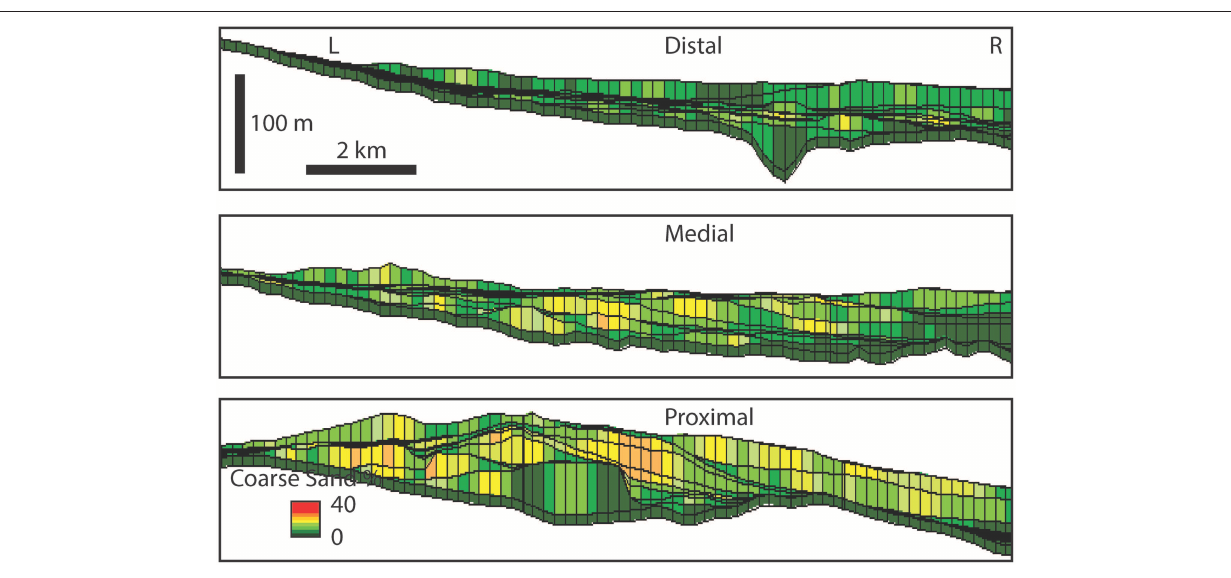
Frontiers in Earth Science |